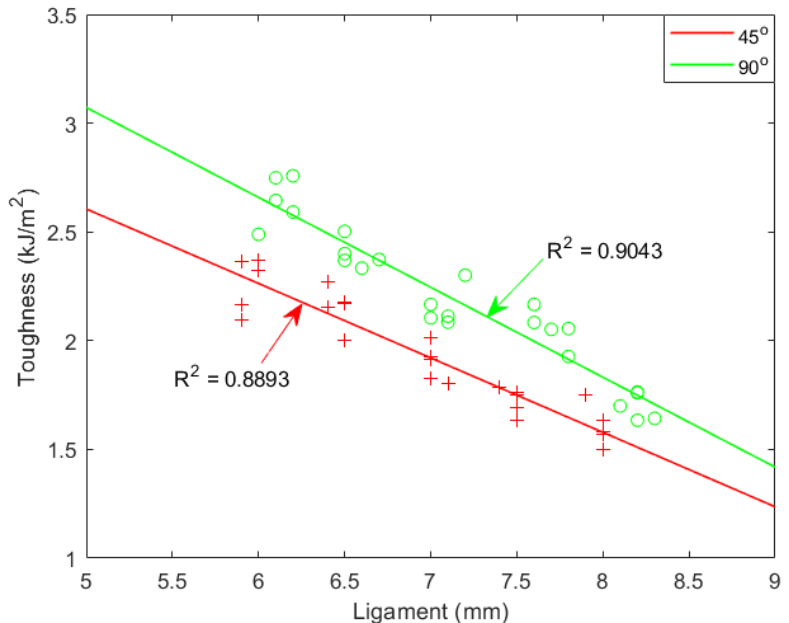
Figure 4. Izod impact toughness with various ligaments. ‘o’ represents Izod toughness with notch angle of 90°; ‘+’ represents Izod toughness with notch angle of 45°.